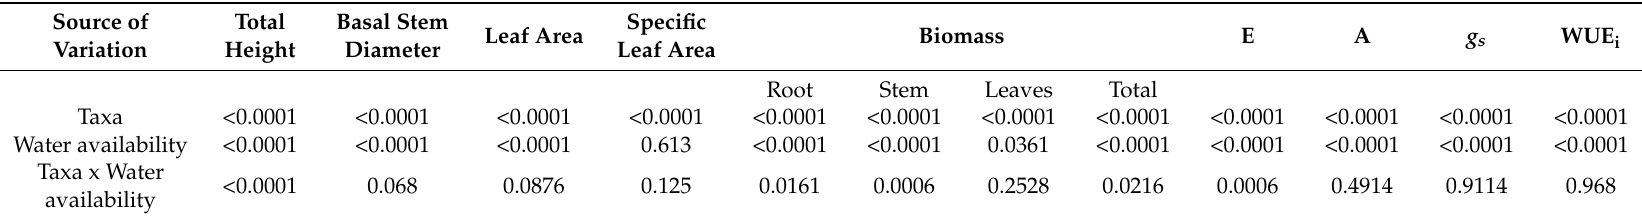
Table 2. Levels of significance ( p -values) from the analysis of variance performed to evaluate the effects of taxa, water availability, and their interaction on the studied variables.